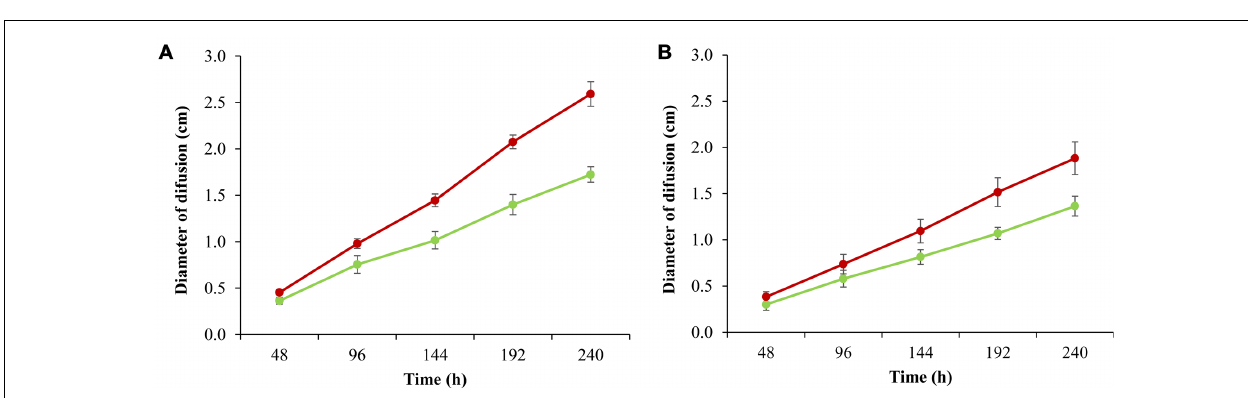
FIGURE 4 | Motility assay for six fast strains (green lines) and six slow strains (red lines) growing at 8 ◦ C in TSAYE medium with 0.20% (A), 0.25% (B) agar. The bars represent one standard deviation. Each point represents the average motility for the strains belonging to each group. Details of the strains in Supplementary Table S1